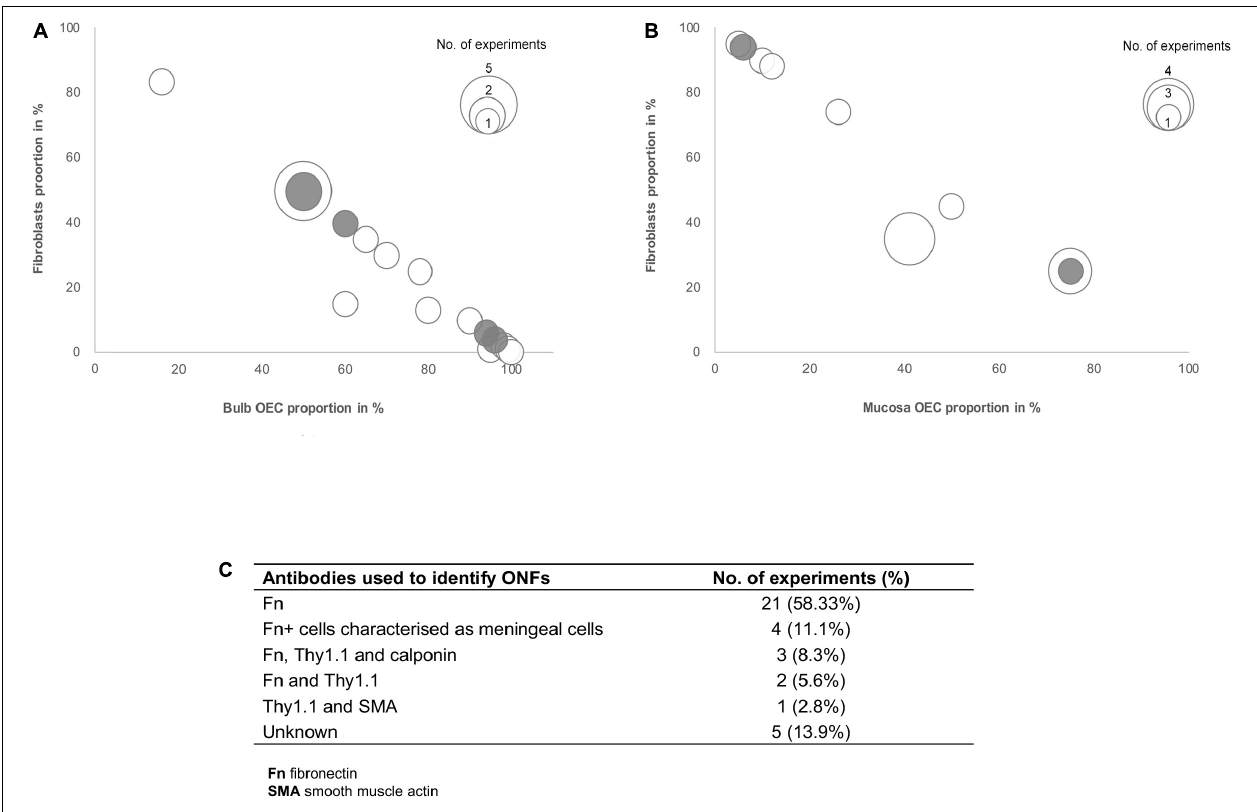
FIGURE 4 | Comparison of the impact of the ratio of OECs to fibroblast proportion in olfactory cell transplants on therapeutic outcome. (A) Comparison of the% proportion of olfactory bulb derived OECs/fibroblast ratio on therapeutic outcome ( n = 21 experiments). (B) Comparison of the% proportion of olfactory mucosa derived OECs/fibroblast ratio on therapeutic outcome ( n = 14 experiments). (C) Immunocytochemical markers used in the characterization of fibroblasts in the studies included in the review ( n = 35 experiments). The white bars represent the positive outcome experiments and the gray bars represent the negative outcome